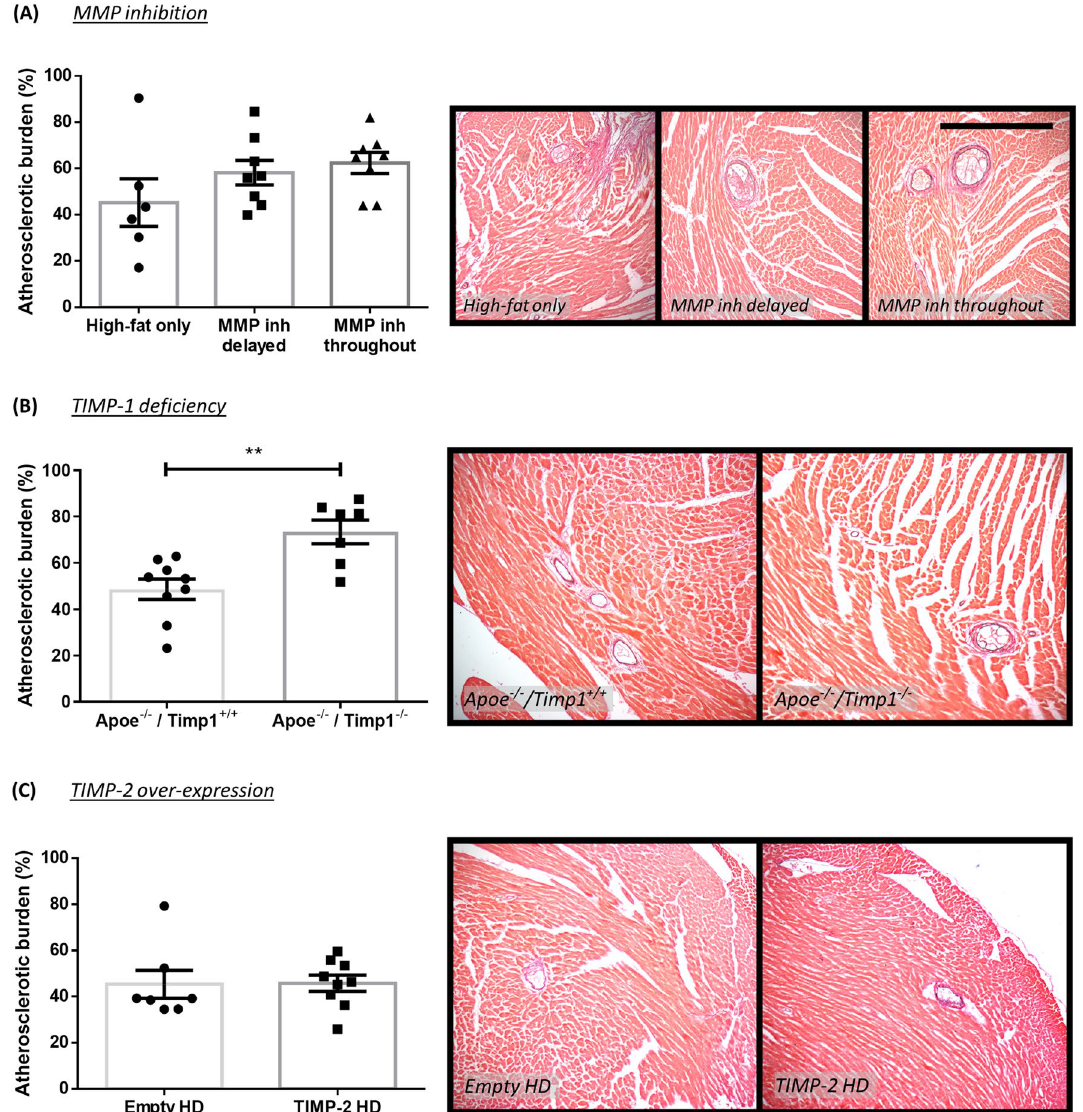
Figure 4. Effect of MMP inhibition and TIMP modulation on coronary artery atherosclerosis in apolipoprotein E-deficient (Apoe -/- ) mice. Quantification and representative images of coronary atherosclerotic burden as assessed in EVG-stained hearts from ( A ) 36-week high-fat fed Apoe -/- mice treated with or without a broad- spectrum MMP inhibitor, ( B ) 36-week high-fat fed Apoe -/- mice deficient for TIMP-1 in comparison to Apoe single knockout controls, and ( C ) 18-week high-fat fed Apoe -/- mice with administration of a TIMP-2 helper- dependent (HD) adenovirus or an empty HD as control. Atherosclerotic burden (%) is presented as average plaque burden/coronary artery/mouse. Statistical significance is reported as ** P < 0.01 using unpaired Students t-test. Scale bar represents 1 mm and is applicable to all panels. In A, n = 6–8/group; in B, n = 7–9/group; in C, n = prevents aberrant fibrosis. The indicated adverse role for MMP-7 in atherosclerosis progression, and potential plaque vulnerability is in accordance with a previous study assessing brachiocephalic artery atherosclerosis in mice 5 , alongside reports of increased macrophage foam cell MMP-7 expression in rupture-prone human carotid plaques 27 , and an association in plasma MMP-7 levels with plaque phenotype and mortality rates 28 . Mechanisti- cally, MMP-7 can cleave N-cadherin from the cell surface of VSMCs, promoting their apoptosis 29 , which may clarify the increased plaque VSMC content observed in MMP-7 knockout mice 5 , and support the association of increased MMP-7 levels with VSMC apoptosis and fibrous cap thinning in murine and human plaques 27,29 . Conversely, our findings imply MMP-7 imparts a protective role during the post-MI cardiac remodelling process. During post-MI remodelling, the healing scar tissue predominantly consists of cardiac fibroblasts and marginating macrophages within the infarct border region, with macrophages and cardiomyocytes (within remote regions) both shown to express comparable MMP-7 levels after MI 30 . However, in an LAD coronary artery ligation mouse model, MMP-7 deficiency was associated with increased macrophage accumulation after MI 30 ;